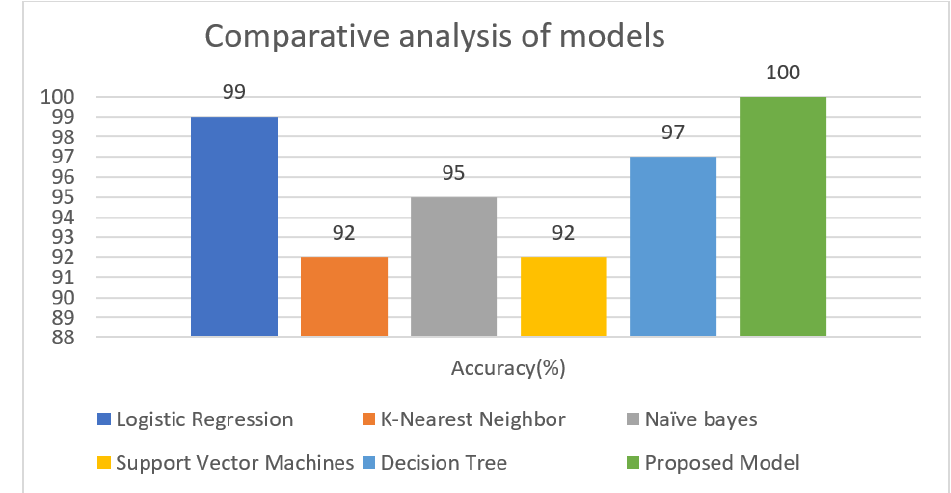
Figure 9. Accuracy graphical representation for the UCI CKD data set.